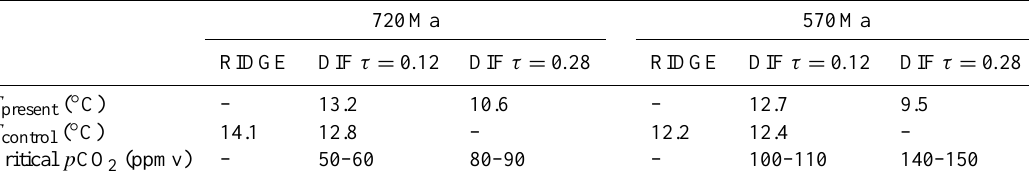
Table 2. Summary of the results of runs. T present is the annually averaged global mean surface temperature obtained at equilibrium under pre-industrial solar insolation and greenhouse gas concentrations, i.e., TSI = TSI 0 , p CO 2 = 286 . 2ppmv. T control is similar to T present except that it is obtained for TSI = 0.94TSI 0 , p CO 2 = 2000ppmv, i.e., the control simulations shown in Fig. 3. Critical p CO 2 indicates the value of p CO 2 for which the climate will enter a hard snowball state. This value is only determined to the precision of 10 ppmv. “RIDGE” indicates that a straight ridge of 2km is added to the ocean floor (see Fig. A1 for their width and locations); “DIF” indicates that ocean bottom is flat but the bottom drag and tracer diffusivities are enhanced (see text).